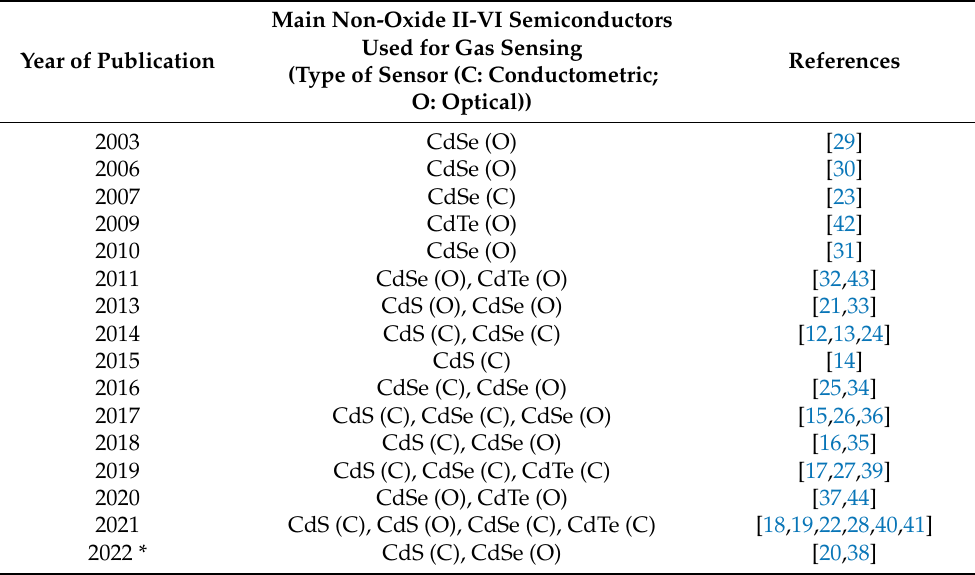
Table 1. Recently published papers on gas sensing technology using CdS, CdSe, and CdTe. Main Non-Oxide II-VI Semiconductors Used for Gas